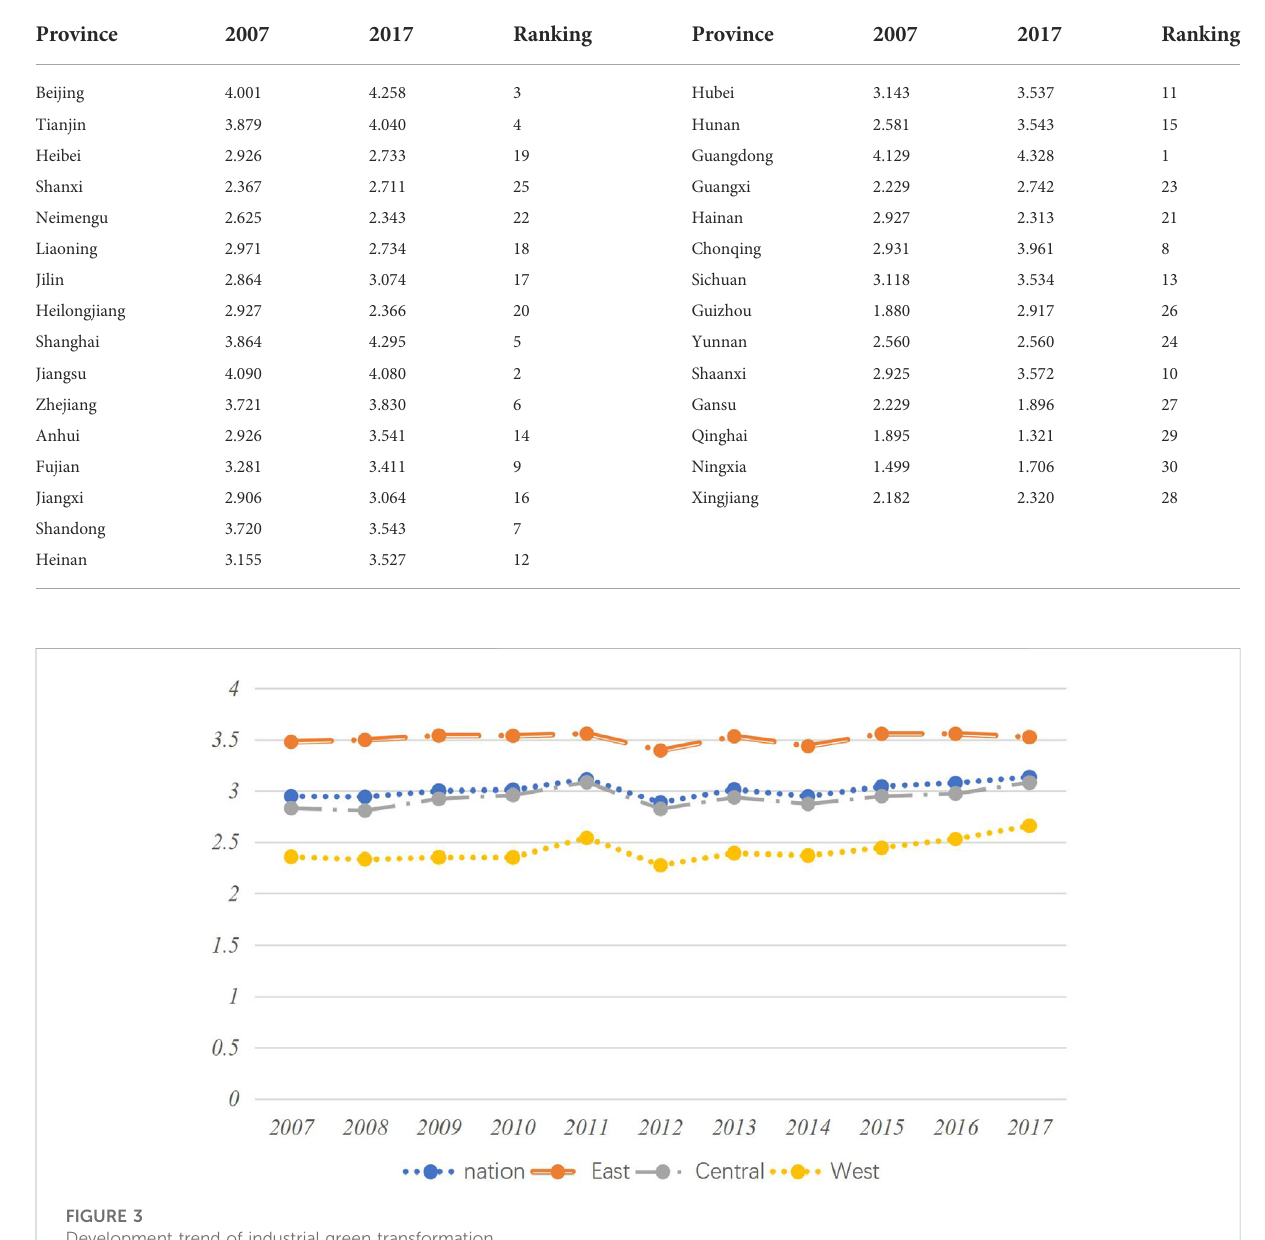
regions is the key to solve the regional imbalance of industrial green development in China.